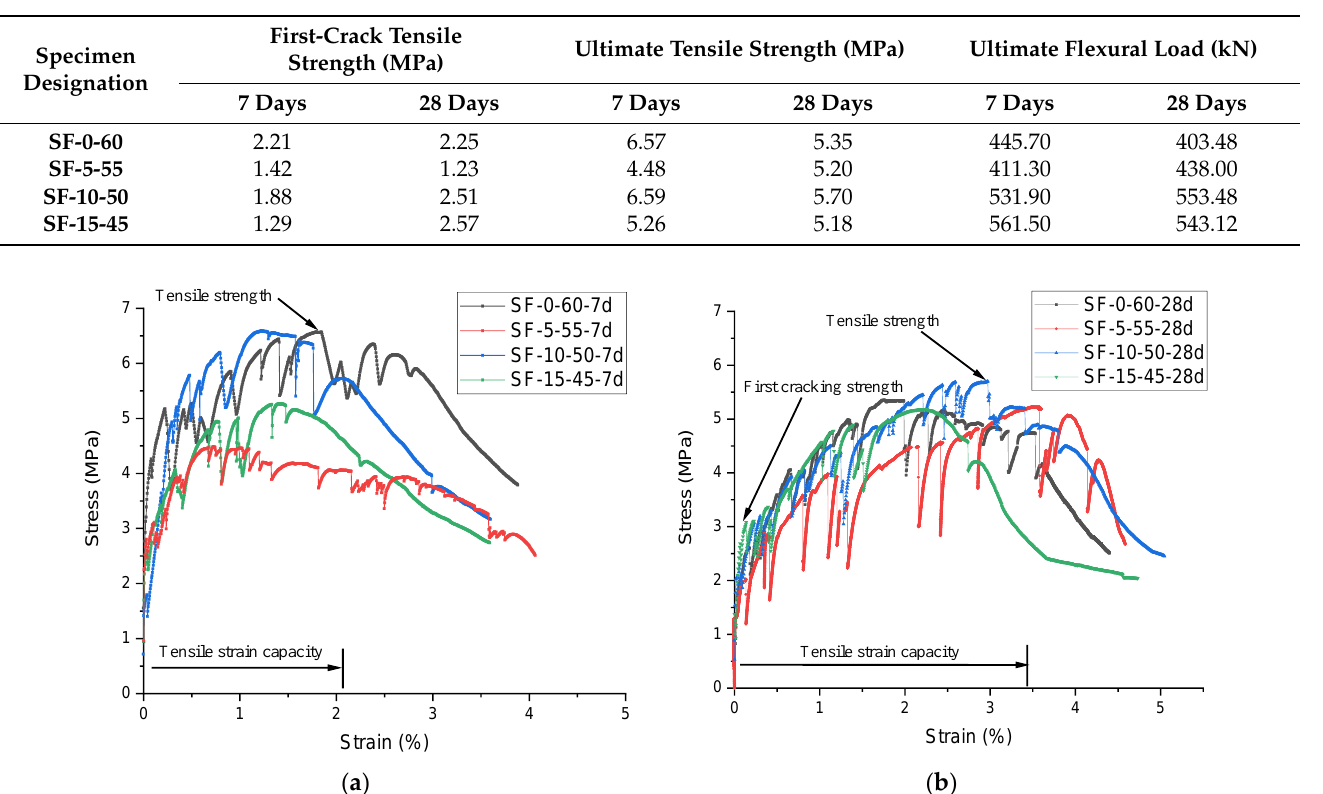
Table 4. Mechanical properties of slag/fly-ash-based ECCs.